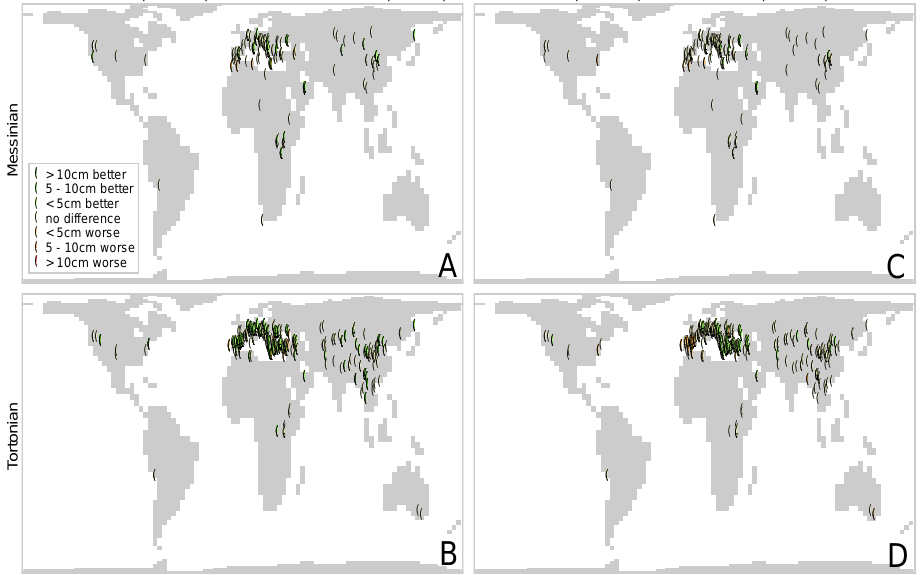
Fig. 14. Improvements in the model–data comparison for mean annual precipitation. The lefthand column (A, B) shows the improvement that the late Miocene palaeogeography makes to the model–data comparison. The righthand column (C, D) shows the improvement that higher CO 2 makes to the model–data comparison. Green circles indicate an improvement; red circles indicate a deterioration. The datapoints showing “no difference” are plotted underneath the other datapoints in order to highlight the